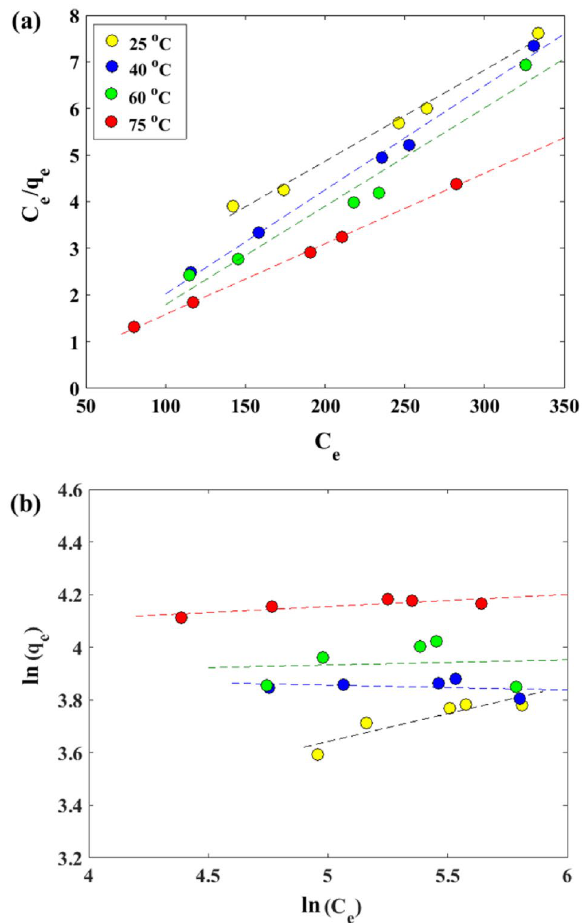
Figure 9. Investigation of adsorption isotherm for ( a ) Langmuir model, ( b ) Freundlich